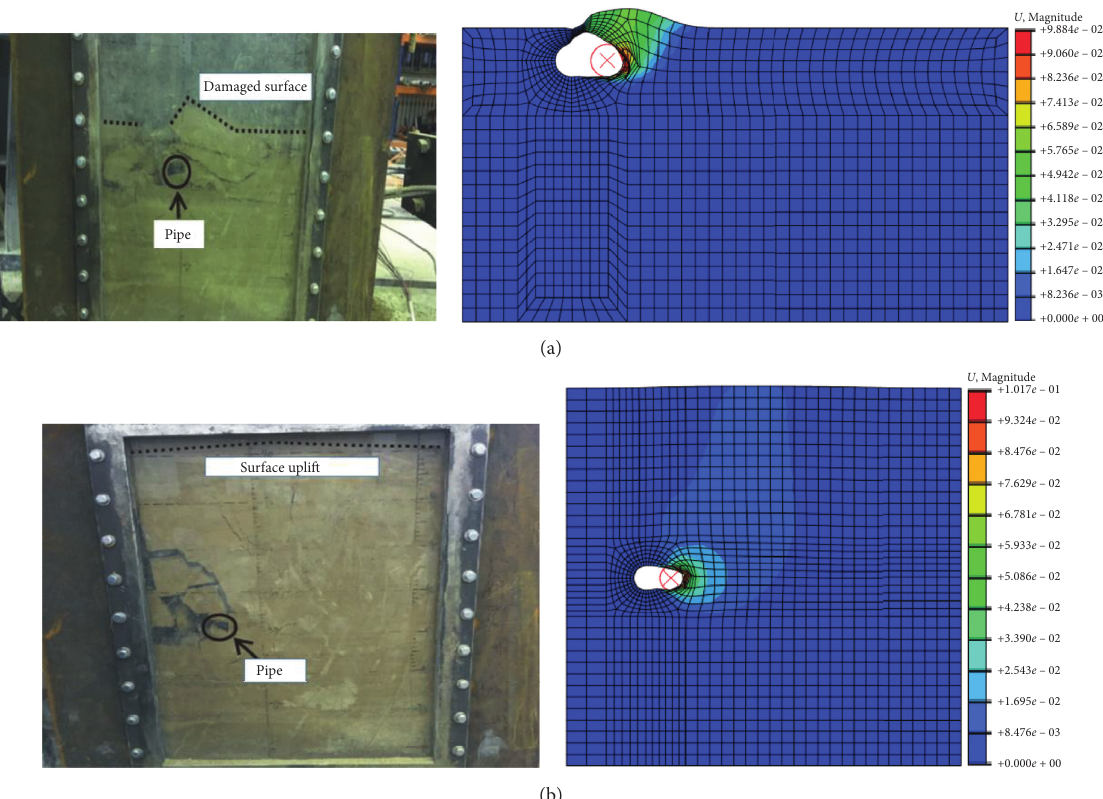
Figure 11: Soil failure modes, in which the left picture is experimental photo and the right picture is the numerical result. (a) D � 60mm, H/D � 1; (b) D � 60mm, H/D �